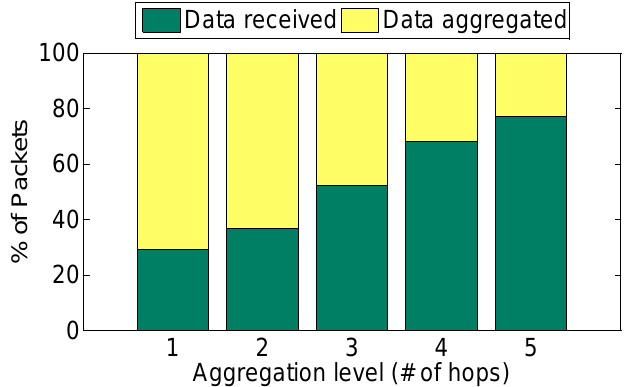
Figure 12. Percentage of packets transmitted and aggregated versus aggregation